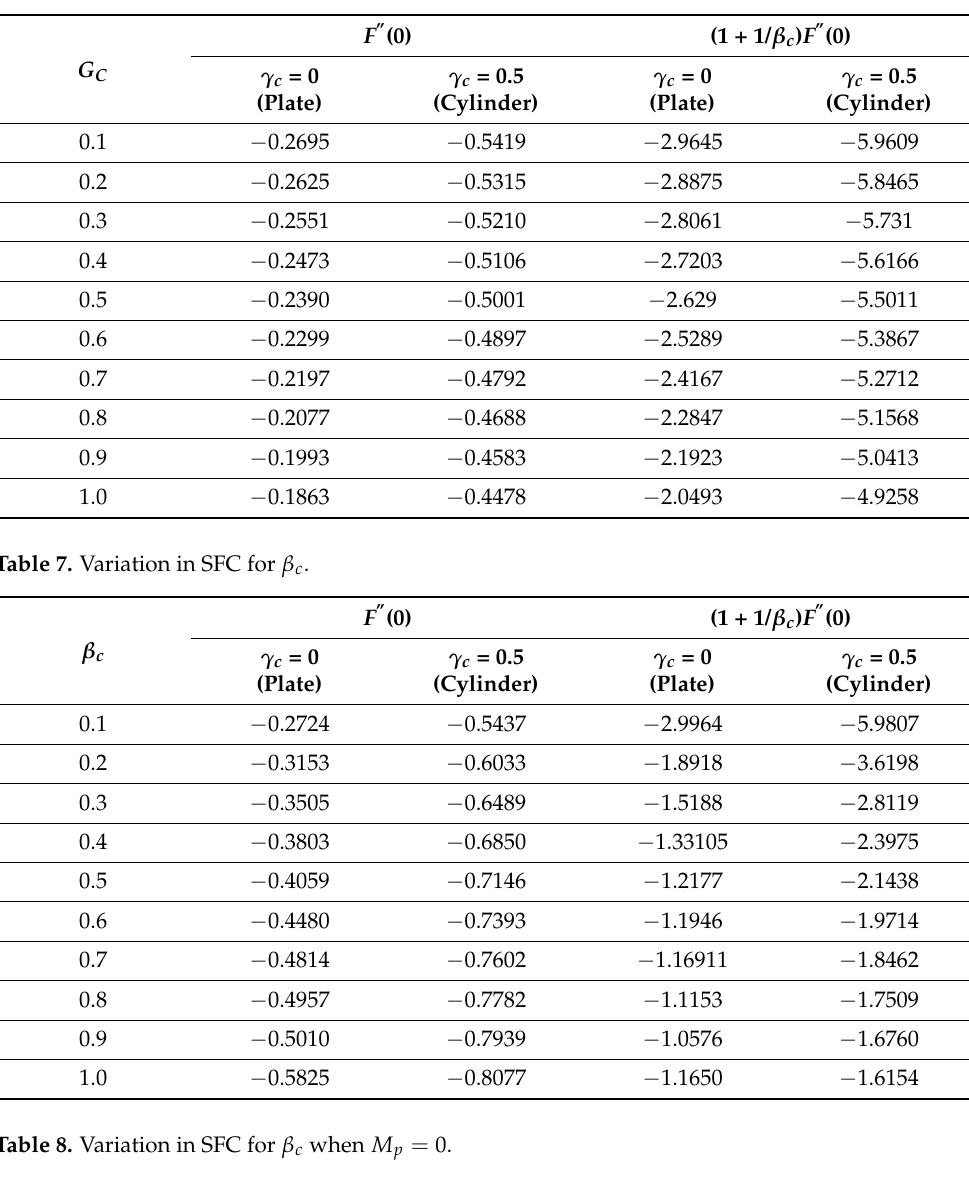
Table 6. Variation in SFC for G C when M p = 0 [21].